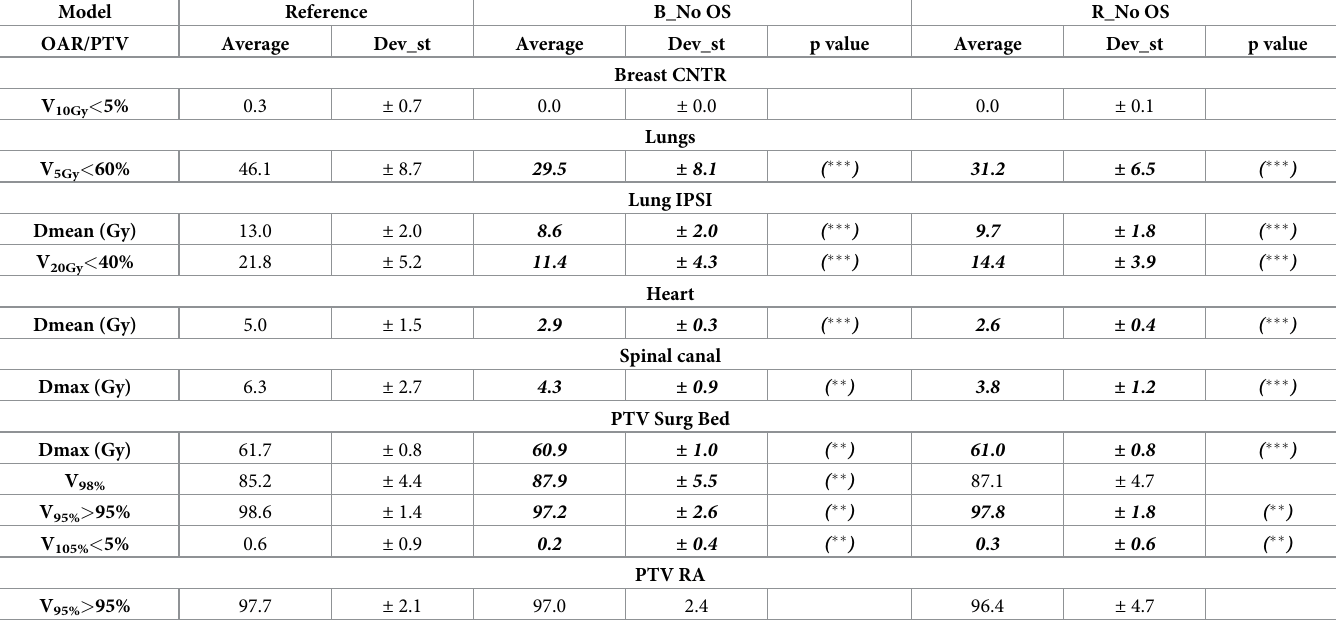
Table 5. Overview and comparison of relevant parameters for both OARs and PTVs, averaged for the 10 patients of the external validation set treated on the right side, both for reference and model-based plans. Model